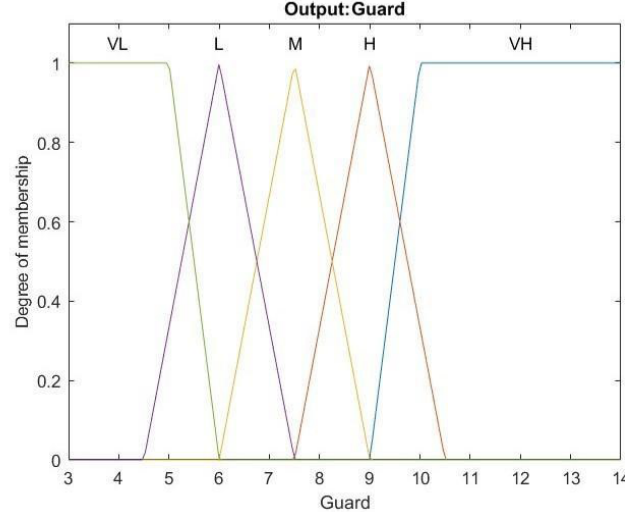
Figure 6. Membership functions for antecedent parts: ( a ) error count and ( b ) error interval.